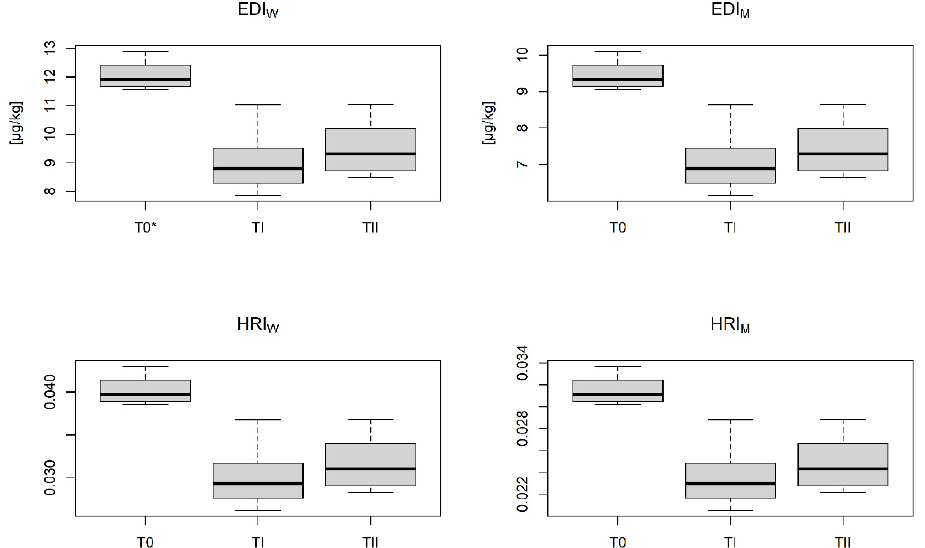
Figure 5. Estimated daily intake (EDI) and health risk index (HRI) calculated for women (W) and men (M) for Zn in camelina; * for descriptions see Material and Methods. Statistically significant differences and p -value are presented in Table 2.